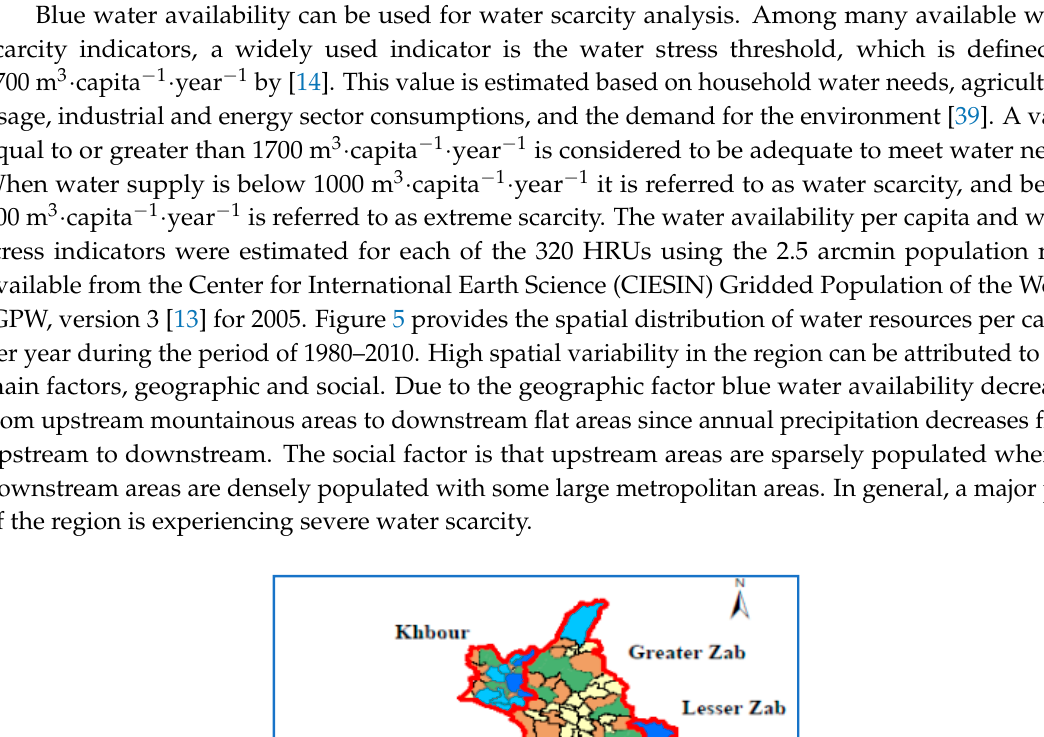
Figure 6. ( Left ) The 1980–2010 average green water storage (Av. GWS) and ( Right ) standard deviation calculated for the number of months per year where the green water storage is available (SD. GWS Avail).